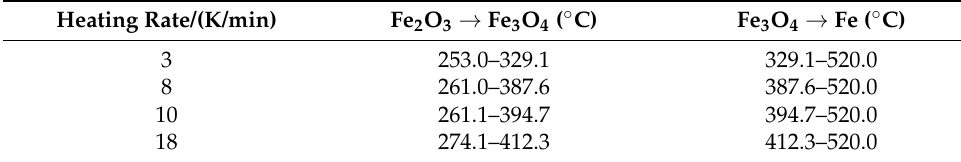
Table 3. The kinetic parameters of the reaction of Fe 2 O 3 → Fe 3 O 4 based on the optimal correlation